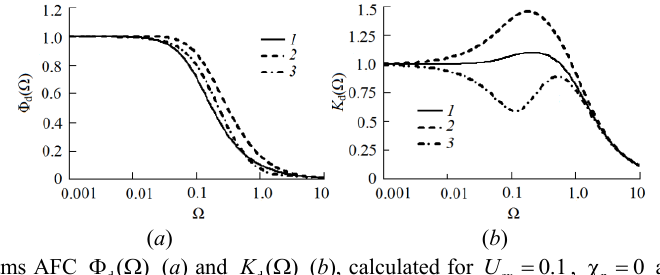
0.1 U  0   and coefficient ex